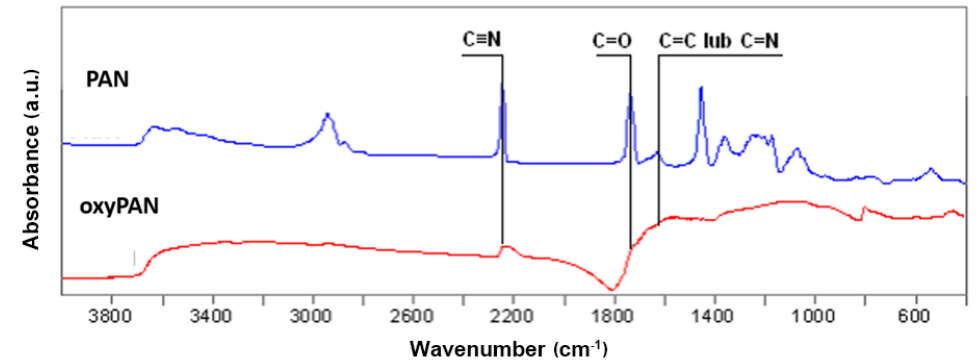
Figure 1. FTIR spectrum of PAN precursor nonwoven fabric and nonwoven fabric after oxidation process (oxyPAN).